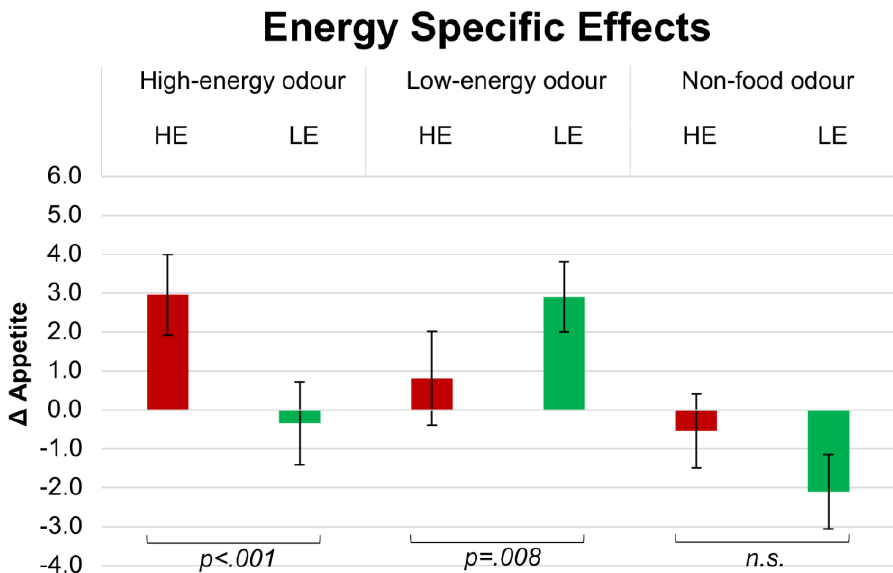
Figure 2. ∆ Appetite (appetite after smelling an odour minus appetite after smelling a baseline reference) for high-energy (HE), low-energy (LE) products after exposure to high-energy (HE), low-energy (LE) and non-food (NF) odours.